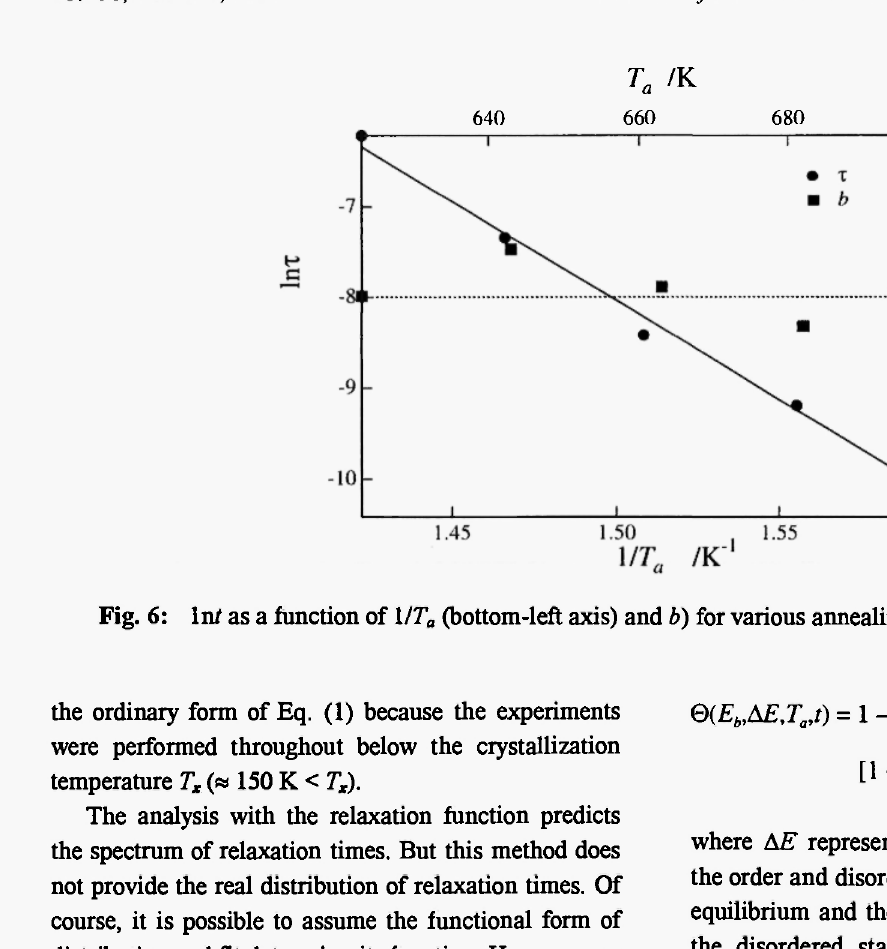
Fig. 6: In/ as a function of UT a (bottom-left axis) and b) for various annealing temperatures (top-right